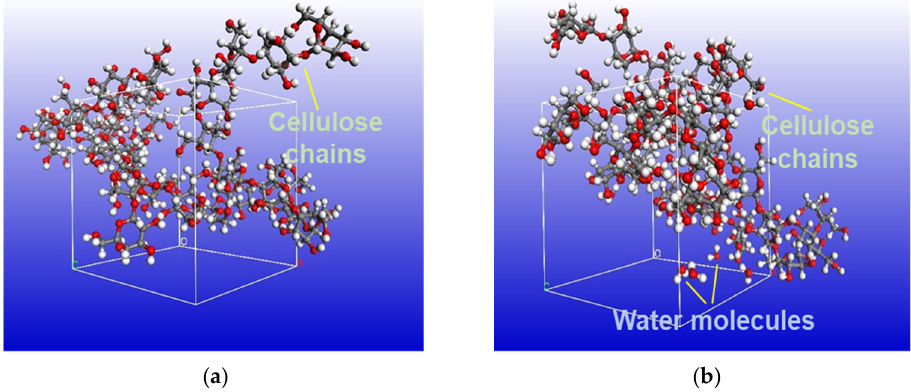
Figure 6. The two cellulose polymer insulation models: ( a ) Cellulose model; ( b ) Cellulose model with 3.5% water.